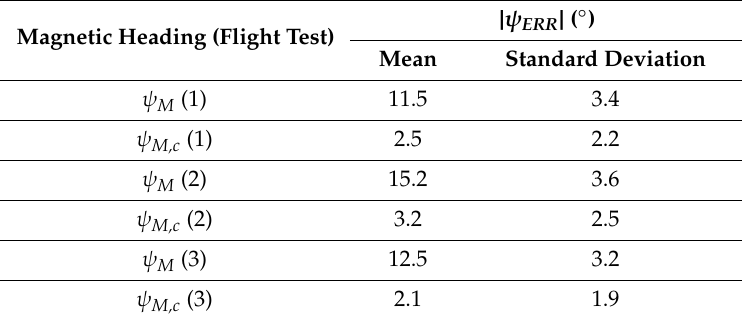
Table 3. Time statistics of the absolute value of the magnetic heading estimation error for the three tests with a flying deputy. Calibrated vs. non-calibrated case. The symbol | · | indicates the absolute value operator. The magnetic heading is corrected using the magnetic bias vector components in BSRF as computed in Section 3.1.2 ( ∆ Hx S = − 267.53, ∆ Hy S = −